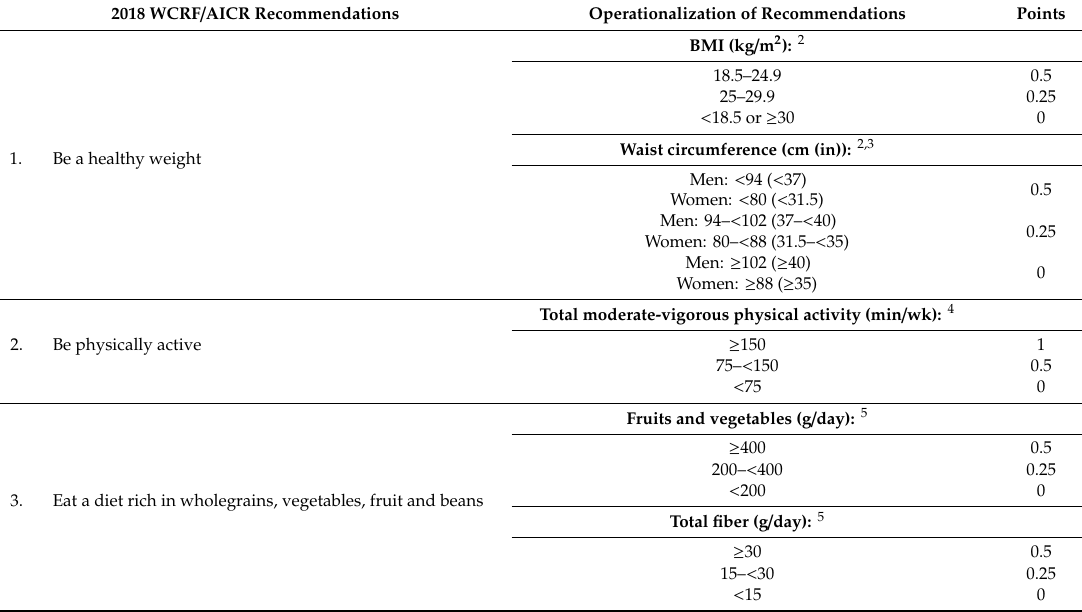
Table 2. A Breakdown of the o ffi cial 2018 WCRF / AICR Score 1